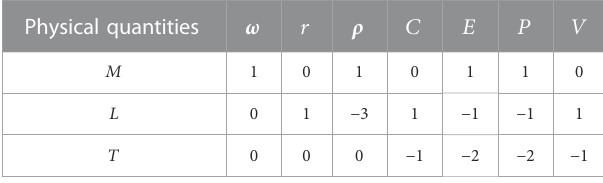
TABLE 4 Each physical quantity dimension power index.